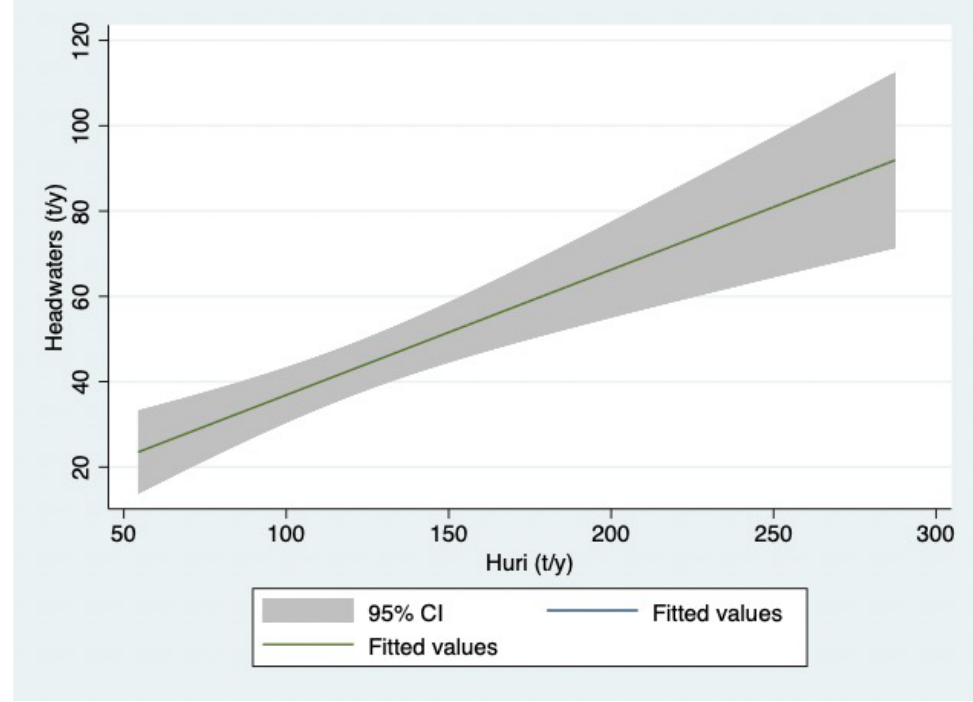
Figure 17. Linear regression (CI 95%) between the TP loading (t/y) of Jordan River in relation to two headwaters, Hazbani and